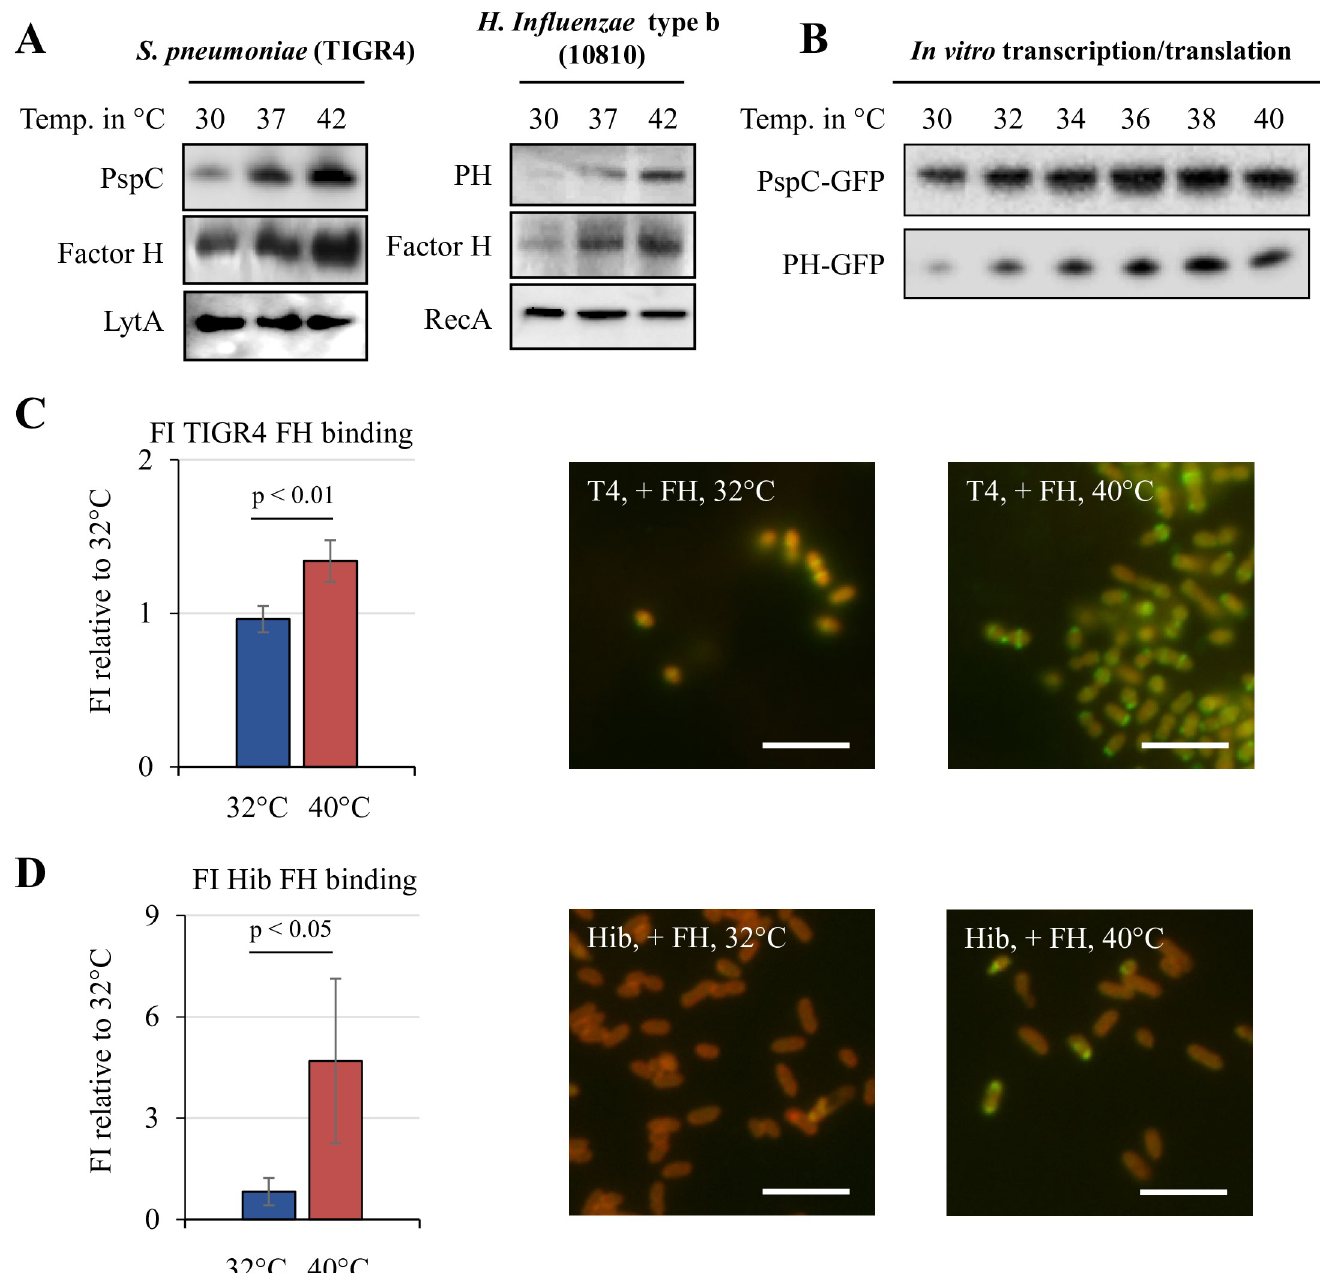
Fig 3. Factor H (FH) binding protein expression of S . pneumoniae and H . influenzae is temperature regulated. (A) Western and far-western blot analyses show thermoregulated PspC and FH expression in S . pneumoniae . Anti-PspC ( S . pneumoniae ) and anti-PH ( H . influenzae ) antibodies used for detection of respective FH binding protein. Human FH was used to determine binding to respective FH binding protein. Anti-human FH antibody was used. LytA ( S . pneumoniae ) and RecA ( H . influenzae ) were used as loading controls. (B) Western blots of in vitro transcription/translation assay of PspC and PH UTR- gfp fusion products show temperature regulation of PspC-GFP and PH-GFP. (Anti-GFP antibody used for detection of GFP). (C) Fluorescent flow cytometry shows increased human FH binding to S . pneumoniae grown at higher temperature. Fluorescent microscopy analysis reveals that more FH is bound to S . pneumoniae at 40˚C (FH binding in a banded pattern). (D) Fluorescent flow cytometry shows increased human FH binding to H . influenzae type b (Hib) grown at higher temperature. Fluorescent microscopy analysis reveals a FH positive population of H . influenzae type b along with a FH negative population at 40˚C. (C & D) Fluorescence intensities of three experiments were pooled and FH binding of bacteria grown at 40˚C vs 32˚C analysed. Error bars denote s.e.m. Statistical significance calculated using a paired, two-tailed student